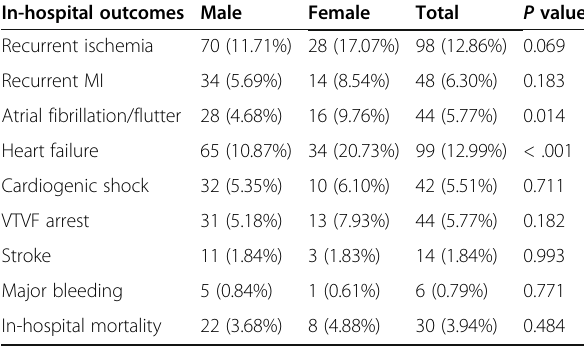
Table 4 Outcome differences of NSTEMI patients by gender In-hospital outcomes Male Female Total P value Recurrent